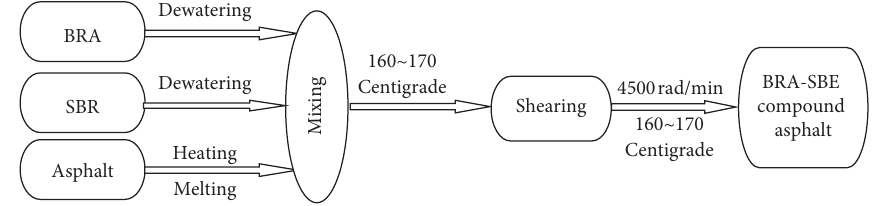
Figure 1: Production process of BRA-SBR compound modified Table 4: Assignations of the Main Bonds of FT/IR Spectra in the main compounds of asphalt. Peak items